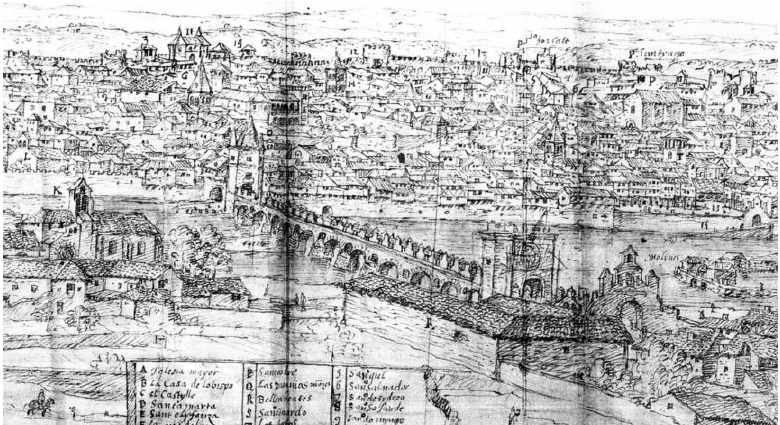
Figure 1. Detail of the Stone Bridge of the Zamora city drawn by Antón van den Wyngaerden, in